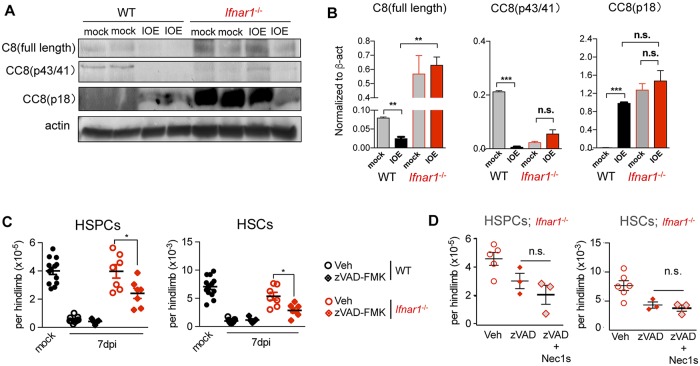
IFNαR-dependent regulation of caspase 8 during IOE infection.(A) Detection of full length (C8), and cleaved caspase 8 (CC8) and β-actin in BM cell lysates from mock and infected WT and Ifnar1-/- mice 7d.p.i. Lanes represent individual mice. (B) Relative amounts of C8 and CC8 p41/43 and CC8 p18 in WT and Ifnar1-/- mock and IOE–infected mice 7 d.p.i., normalized to β-actin. (C) HSPCs and HSCs in mock and vehicle (veh) control- or zVAD-FMK-treated infected WT and Ifnar1-/- mice 7 d.p.i. n = 5–13 mice/group. (D) Vehicle-, zVAD-FMK-treated, or zVAD-FMK- and Necrostatin-1s treated Ifnar1-/- mice day 7 p.i. n = 3–5 mice/group. *P < 0.05, **P < 0.001, ***P < 0.0001.